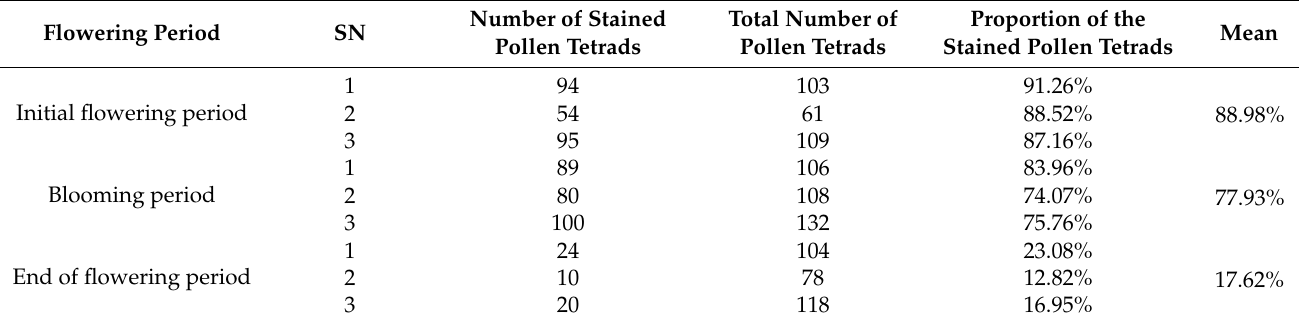
Figure 6. Pollen tetrads, stained in different periods. ( A ): in the initial flowering period; ( B ): in the blooming period; ( C ): in the end flowering period. Table 2. Measurement of stained pollen tetrads in different